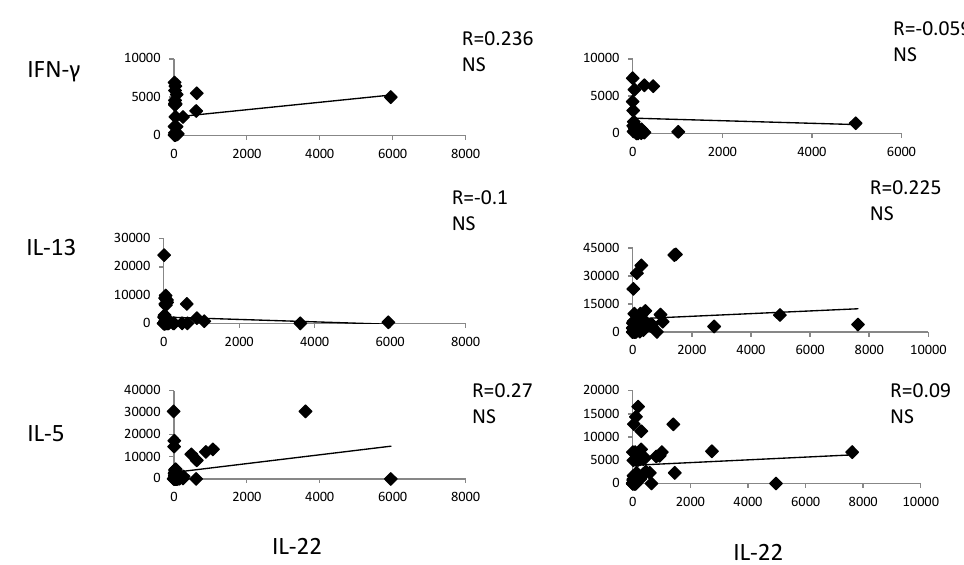
Figure 2. In those experiencing successful pregnancy, IL-22 is positively correlated with IL-4, whereas, in those experiencing URA, IL-22 produced by CD4+ T cell clones derived from the decidua is positively correlated with IL-17A and IL-17F. The levels of IL-22 and the levels of IL-4, IL-13, IL-5, IL-17A, IL-17F, and IFN- γ measured in the supernatants of the CD4+ T cell clones derived from deciduae of those experiencing unexplained recurrent abortion (URA) and those experiencing successful pregnancy (Experiment 1 in section 4.3) have been correlated. NS means that p is not significant.